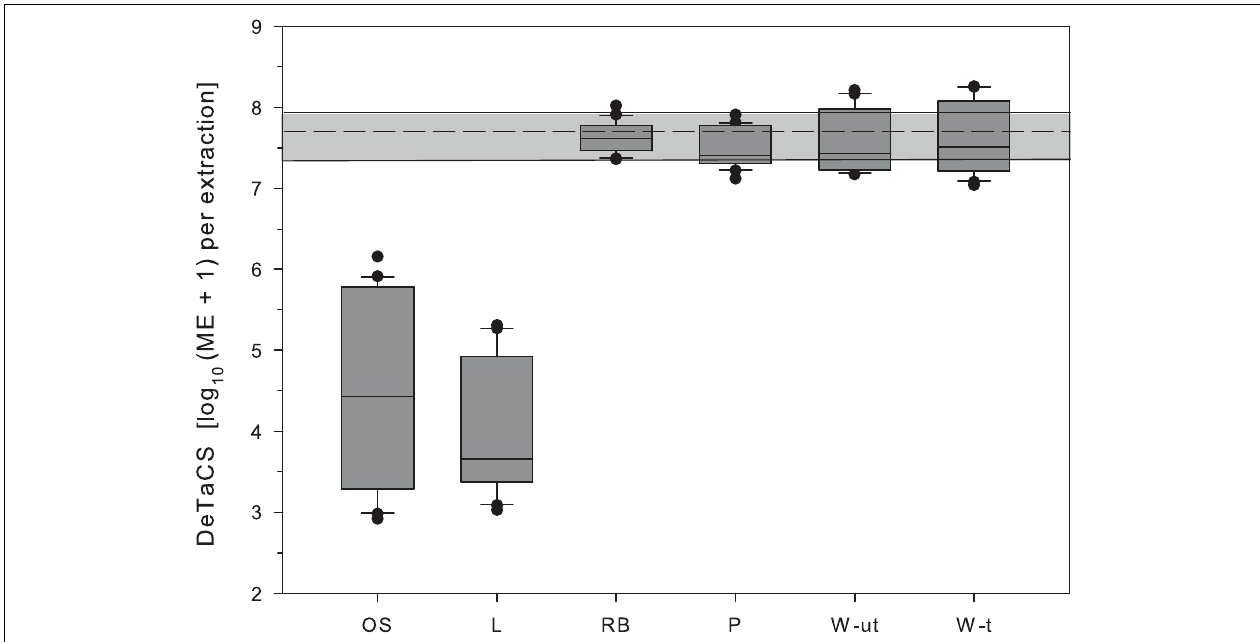
FIGURE 1 | Retrieval of DeTaCS marker concentrations from environmental samples of the study area to test the hypothesis that the sample matrix can affect DNA extraction efficiency. Environmental water samples were spiked with the reference cell standard during filtration directly into the sample. The given sample order reflects the gradient from high to low inorganic TSS fraction (OS > L >> RB > P > W-ut > W-t). OS, shallow soda lake Oberer Stinker; L, Lake Neusiedl; RB, reed belt; P, stabilization pond; W-ut, untreated wastewater; W-t, treated wastewater. Boxes, 25th and 75th percentile; lines within the boxes, median; whiskers, 10th and 90th percentile, respectively. The gray area spans the 10th–90th percentile of the DeTaCS marker concentration in the extraction controls. The dashed line marks the median. n = 22.